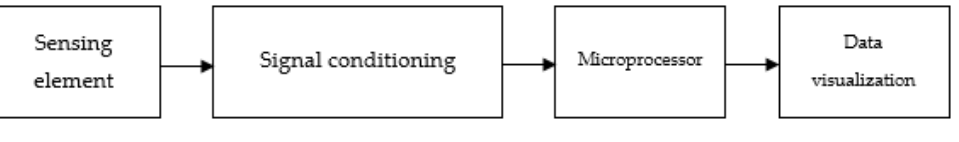
Figure 4. Smart sensor logic diagram.